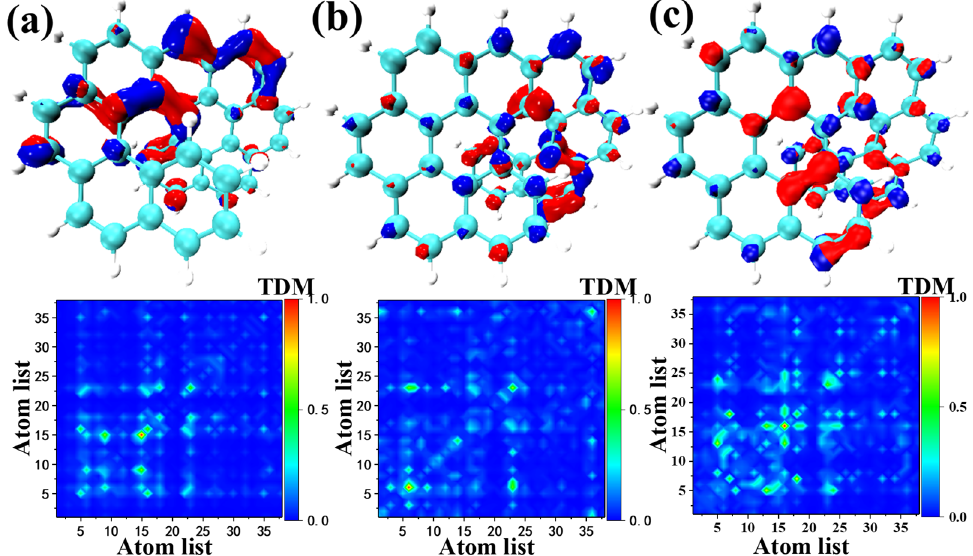
Figure 5. Electron-hole analysis diagram (upper) and transition density analysis diagram (lower) of O9H: S 1 ( a ), S 6 ( b ), and S 12 ( c ). O9H: S 1 ( a ), S 6 ( b ), and S 12 ( c